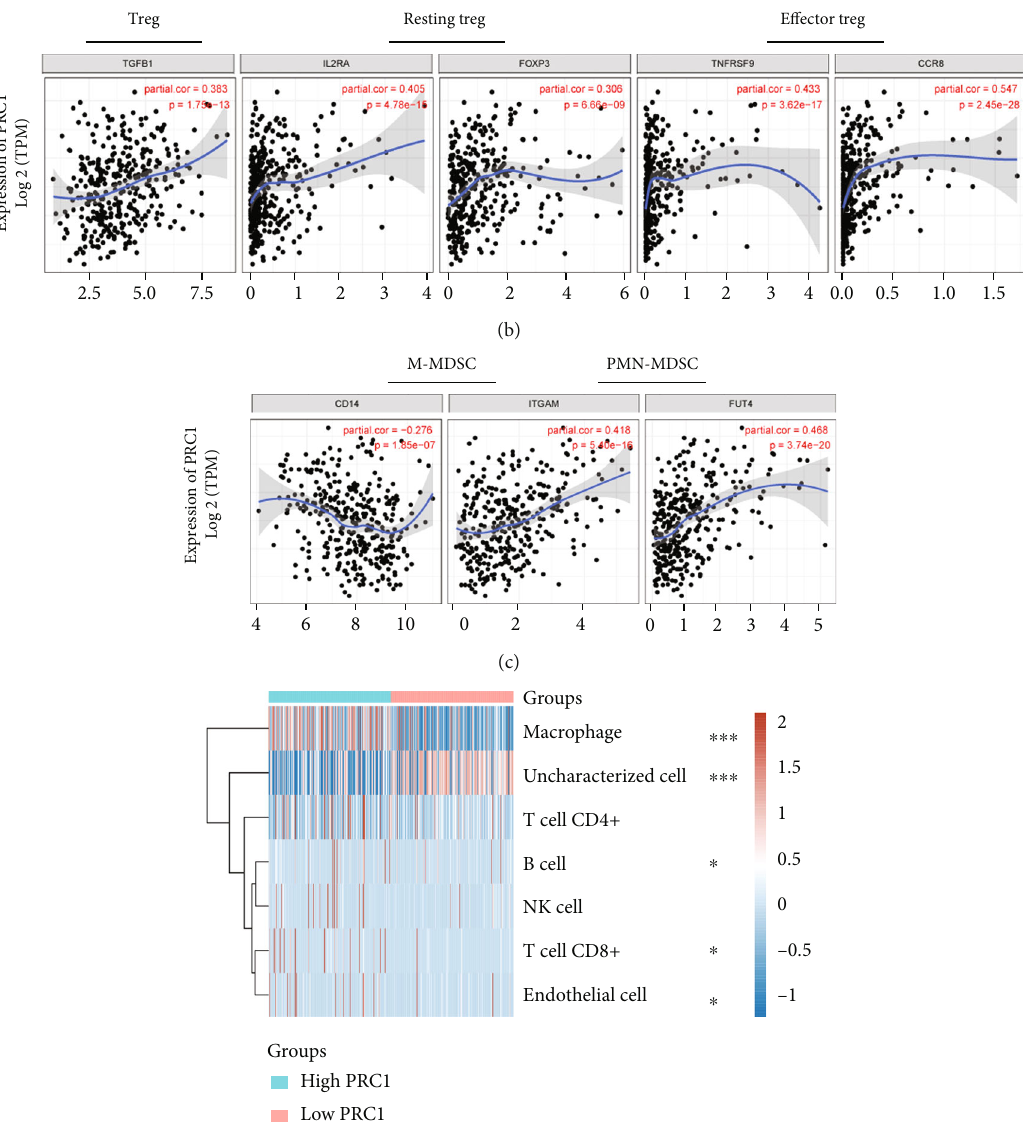
Figure 8: PRC1 overexpression was positively correlated with suppressive immune cells ’ in fi ltration and negatively related with e ff ector immune cells ’ in fi ltration. (a) Pan-cancer correlation analysis of the PRC1 expression and the in fi ltration of Treg and MDSC cells. (b – c) Correlation of the expression of PRC1 and the marker genes of Treg and MDSC in LIHC. (d) The association between the PRC1 expression and the macrophage, B cell, CD4+ and CD8+ T cell, NK cell, and endothelial cell. ∗ p < 0 : 05 ; ∗∗∗ p < 0 : 001